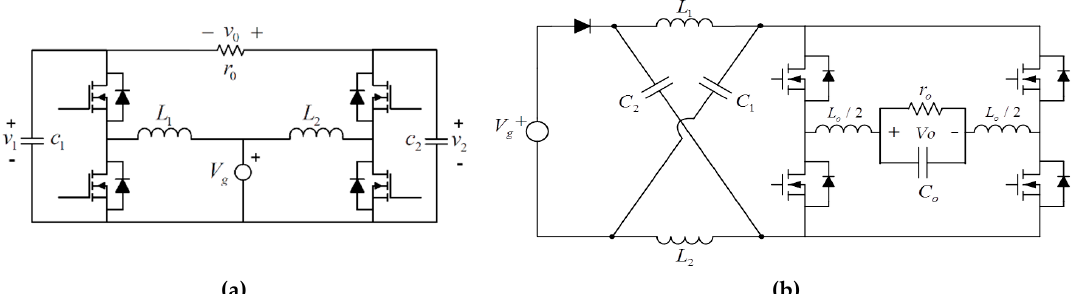
Figure 3. Single-stage transformerless inverters with small voltage gain: ( a ) Boost inverter (Barbi), and ( b ) Z-source single-phase inverter.